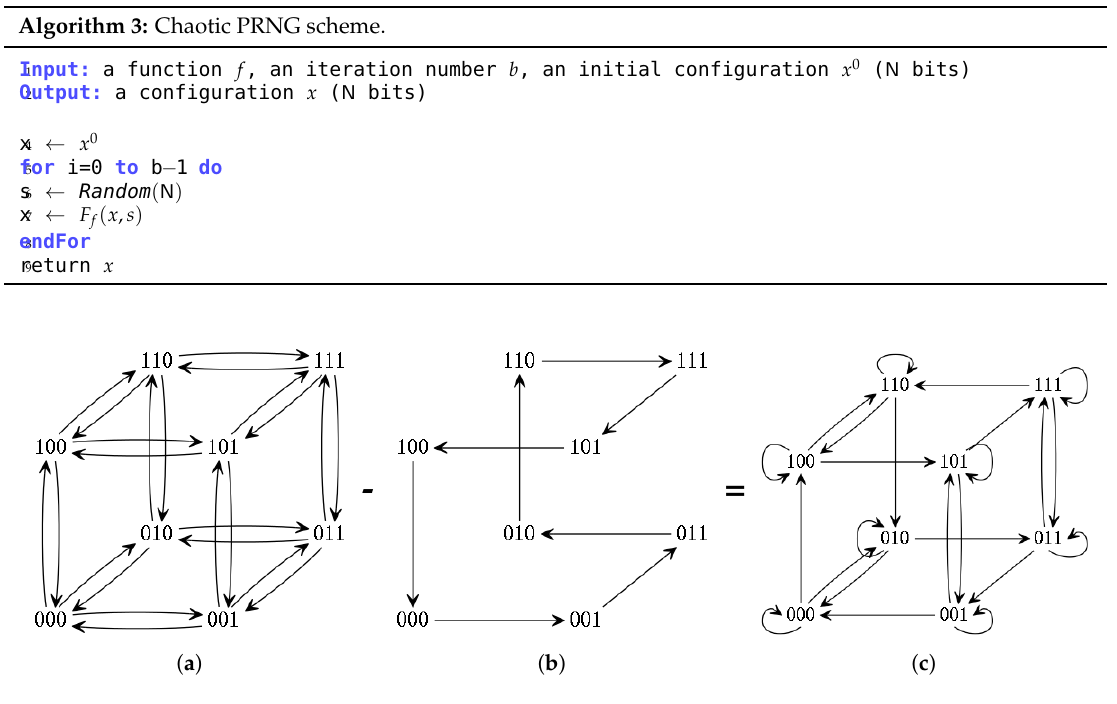
Figure 6. Construction of function f in dimension 3. ( a ) Original 3-cube; ( b ) A Gray code; ( c ) Function f